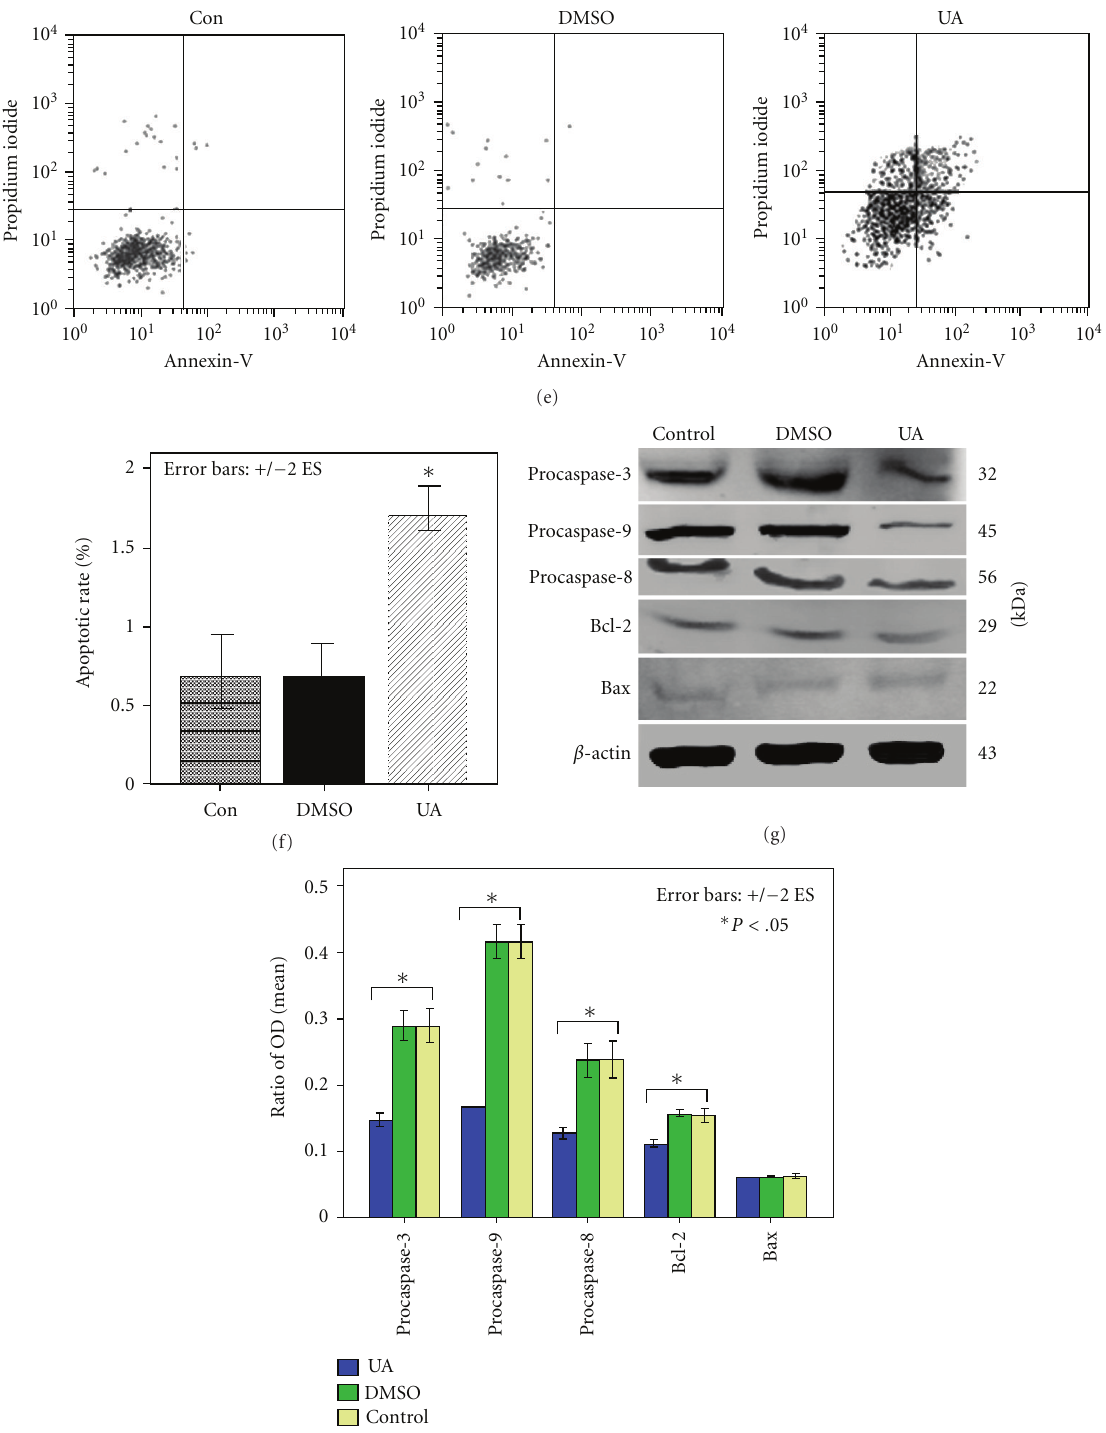
Figure 1: UA inhibited proliferation and induced apoptosis in gastric cancer cell BGC-803. (a) Inhibition of proliferation of BGC-803 was assessed by MMT staining. (b) Morphological changes of BGC-803 cells after UA (IC 50 (24h)) treatment for 24 h (Bar represents 200 μ m); magnified image of cells was showed in corner (Bar represents 200 μ m). (c) H&E staining of BGC-803 cells after UA (IC 50 (24h)) treatment for 24h (Bar represents 200 μ m), and arrows indicated apoptotic cells; magnified image of cells was showed in corner (Bar represents 200 μ m). (d) DNA ladder was found in BGC-803 cells treated with UA (IC 50 (24h) and IC 50 (36h)), not in BGC-803 cells treated with 0.2% DMSO or without treatment. (e) Apoptosis of BGC-803 cells induced by UA was detected by Annexin-V staining and flow cytometry. (f) was the quantified data from experiment showed in (e). Apoptotic rate was 0 . 66 ± 0 . 15, 0 . 67 ± 0 . 08, and 1 . 69 ± 0 . 11 in control, DMSO, and UA treated cells, respectively, ( ∗ P < . 01). (g) Western blot showed expression of apoptotic related genes in BGC-803 cell treated with DMSO, UA and without treatment; β -actin was used as internal control. (h) showed related amount of protein from (g) ( ∗ P < .